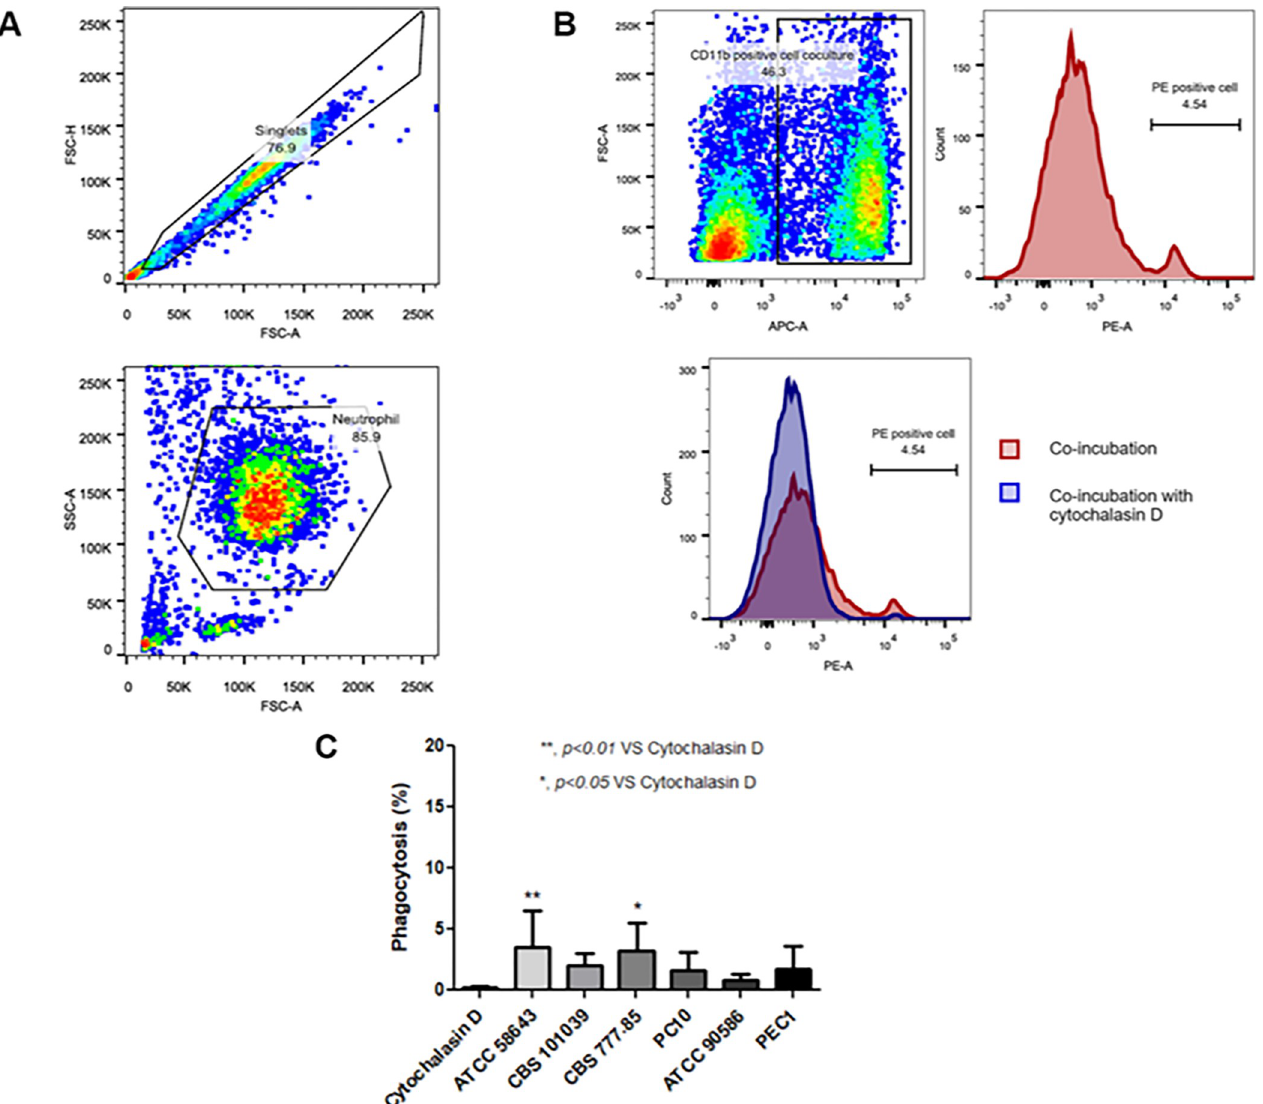
Fig 2. Phagocytosed zoospores from six strains of P . insidiosum by human neutrophils (n = 6). (A) Representative flow cytometry result of gated neutrophils after co-culture with zoospores. (B) Representative histogram pictures of gated neutrophils and PE-positive cells indicating phagocytosed zoospores of P . insidiosum and gated neutrophils pretreated with or without cytochalasin D (negative control). (C) The percentages of phagocytosis after neutrophils incubated with zoospores compared with cytochalasin D treatment in each strain. ( �� p < 0.01, � p < 0.05). https://doi.org/10.1371/journal.pone.0280565.g002 when neutrophils were treated with zoospores from all six strains of P . insidiosum ; CBS 777.85 (48 ± 9.3%), ATCC 90586 (41 ± 5.6%), PEC1 (39 ± 7.5%), PC10 (39 ± 6.3%) ( p < 0.001, n = 6), ATCC 58643 (33 ± 9.3%) ( p < 0.01, n = 6), when compared with untreated neutrophils (Fig 3B and 3C). However, the levels of cell-free DNA (as a marker of NET products in cell culture medium) were significantly increased when neutrophils were treated with zoospores from all strains of P . insidiosum ; CBS 777.85 (100.80 ± 12.17 ng/ml), ATCC 90586 (98.73 ± 7.08 ng/ ml), PEC1 (93.68 ± 5.40 ng/ml), PC10 (91.65 ± 4.92 ng/ml), ATCC 58643 (72.70 ± 8.42 ng/ml) ( p < 0.001, n = 6), and CBS 101039 (61.53 ± 11.01 ng/ml) ( p < 0.01, n = 6), when compared with untreated neutrophils (Fig 3D).